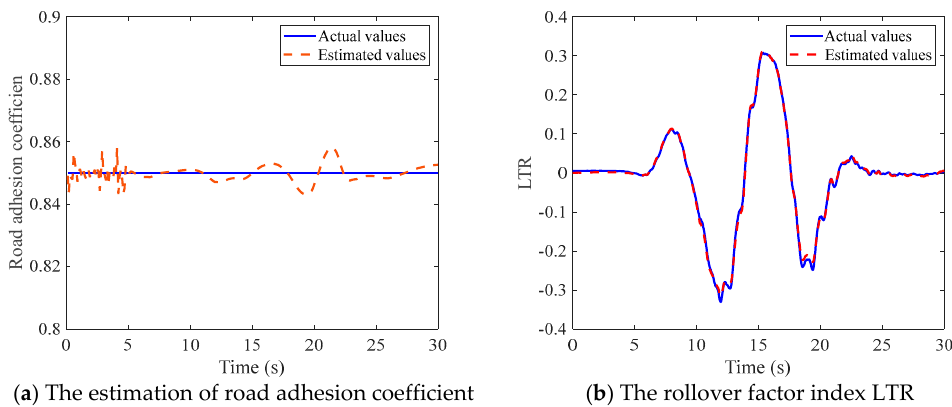
Figure 18. The estimation of the road adhesion coefficient and the rollover factor index LTR.